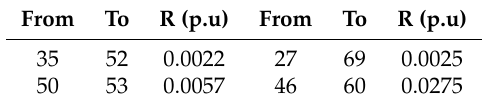
Table 2. Proposed connections to test the mesh grid case for the 69-bus test system. From To R (p.u) From To R